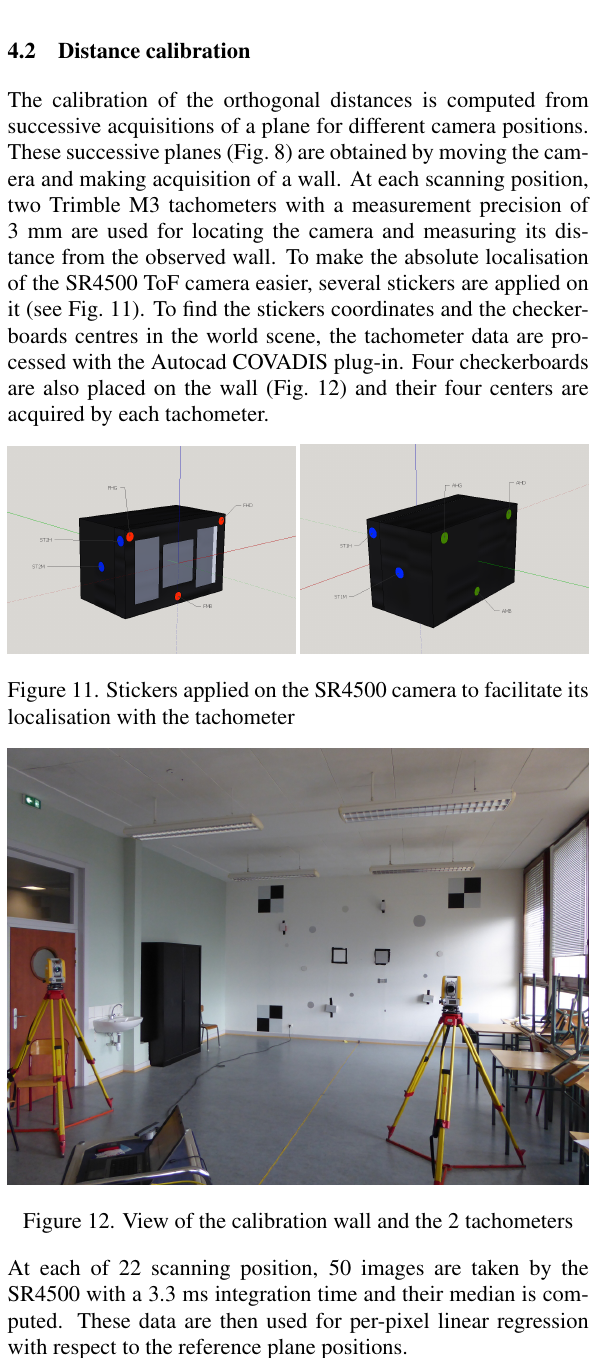
Figure 12. View of the calibration wall and the 2 tachometers At each of 22 scanning position, 50 images are taken by the SR4500 with a 3.3 ms integration time and their median is com- puted. These data are then used for per-pixel linear regression with respect to the reference plane positions.